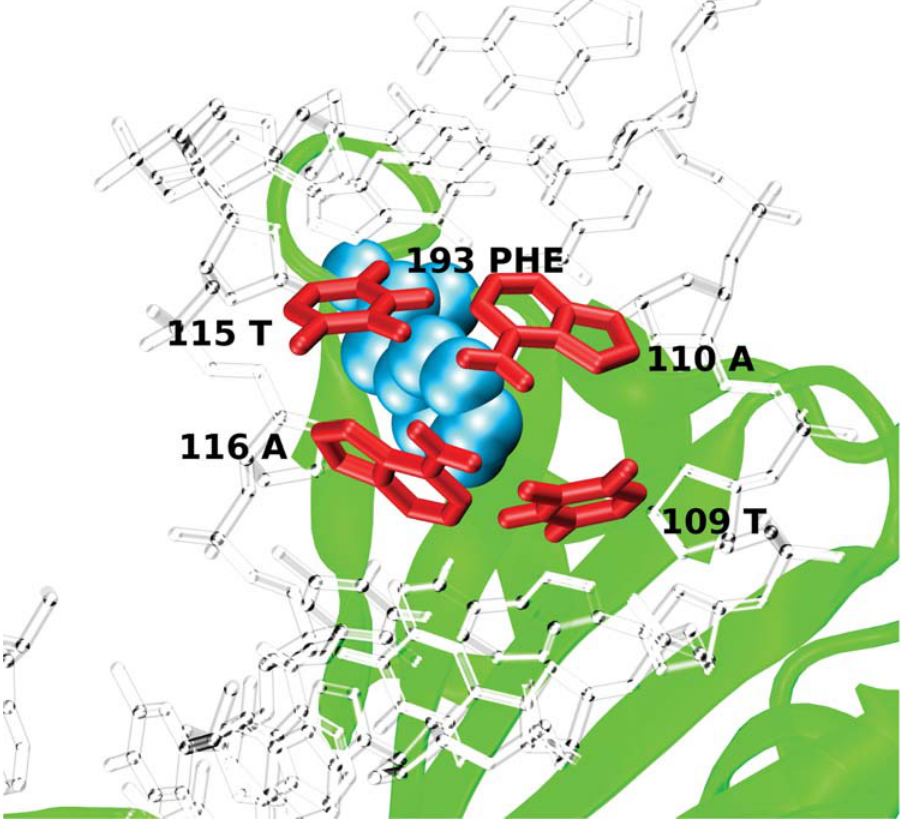
Figure 4. A protein-base (P-B) hub in TATA box binding protein (TBP/DNA). An amino acid interacts with four different bases to form a P-B hub. In the TATA box binding protein (1tgh) the position of a P-B hub Phe193 (at MEC 3%) is shown. This hub (blue) interacts mainly with bases from four different nucleotides (red) T115, A116, T109, and A110.